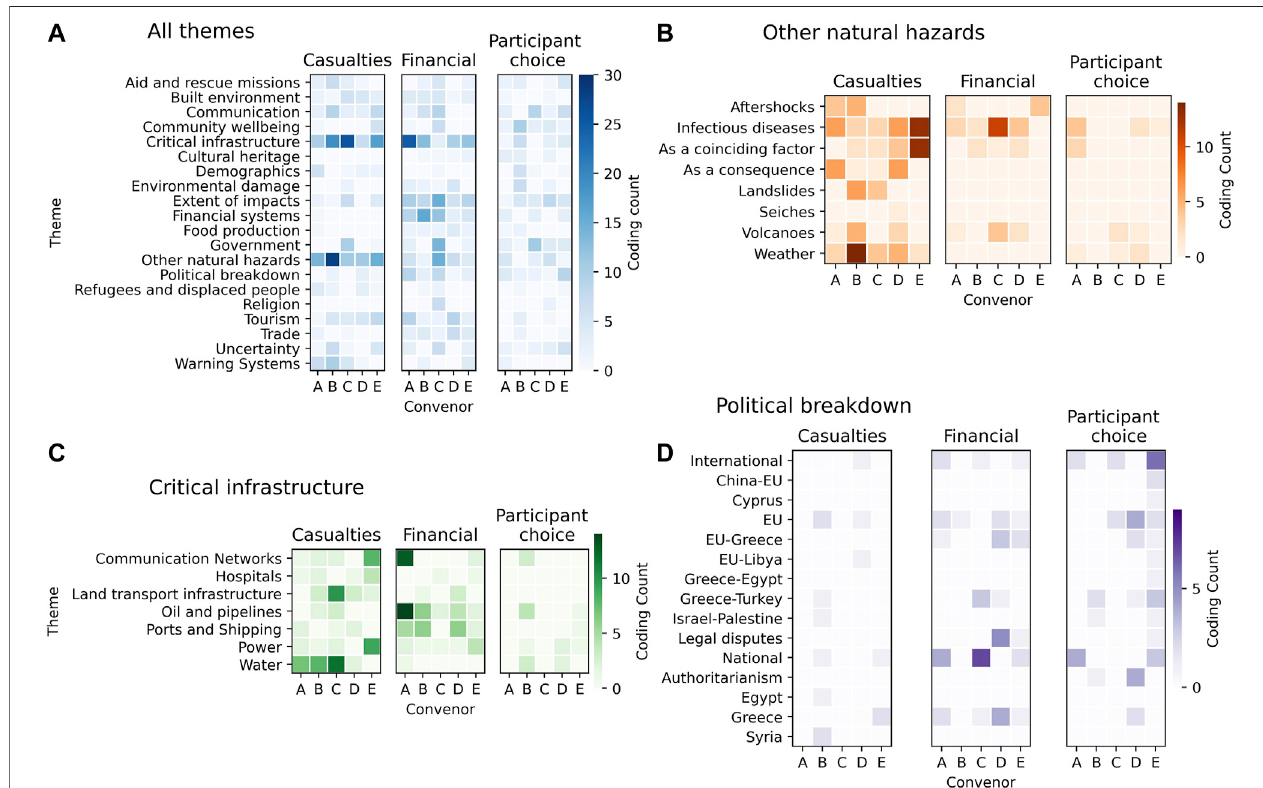
FIGURE 5 | Heat maps of themes discussed by different groups in different rounds. (A) shows the overall themes discussed and (B) , (C) and (D) show more detailed breakdowns of the “ other natural hazards, ” “ critical infrastructure, ” and “ political breakdown ” themes respectively. Note that for “ political breakdown, ” the code “ international ” encompasses both coding generically as international political breakdown and the speci fi c instances listed between “ international ” and “ national ” . Similarly, “ national ” includes both coding with “ political breakdown-national ” and the codes listed below ‘ national ” .